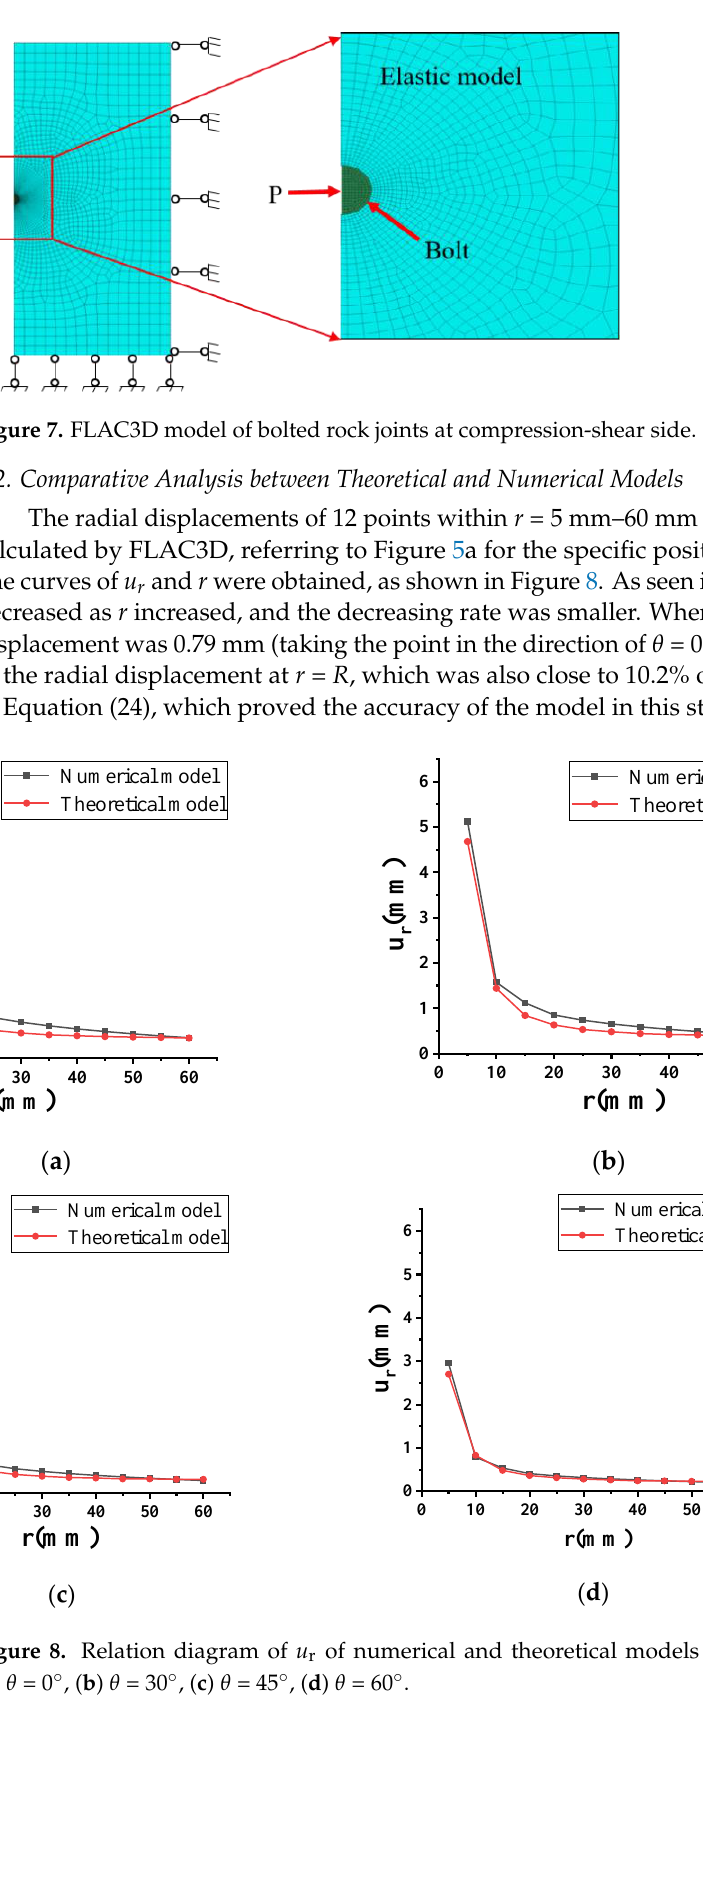
Figure 7. FLAC3D model of bolted rock joints at compression-shear side. Table 1. Mechanical parameters of bolt